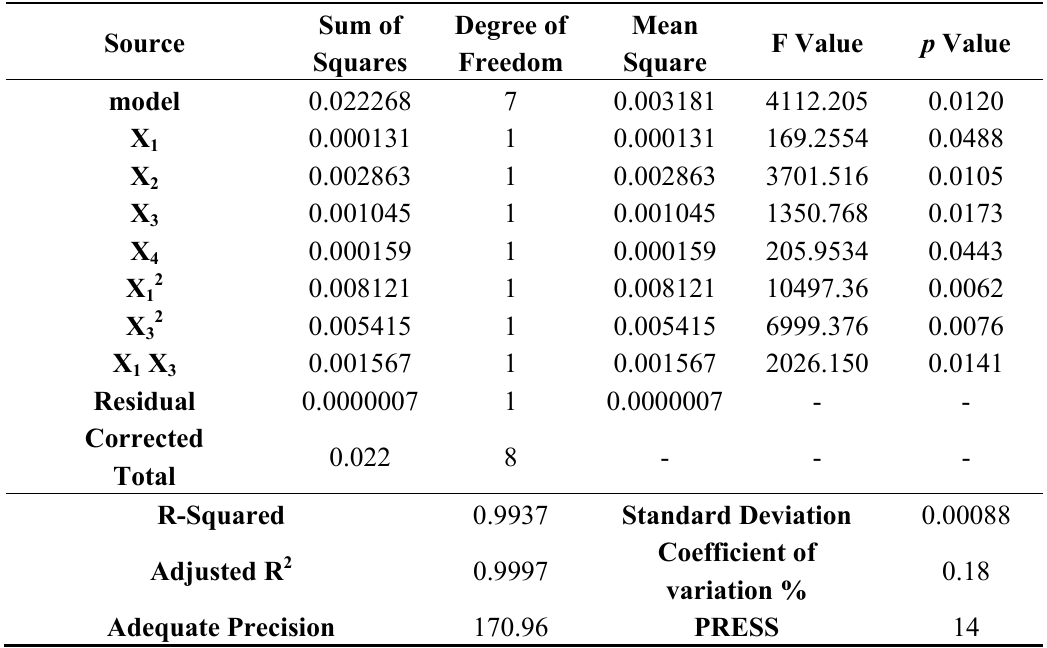
nanocrystalline deposition parameters. 2